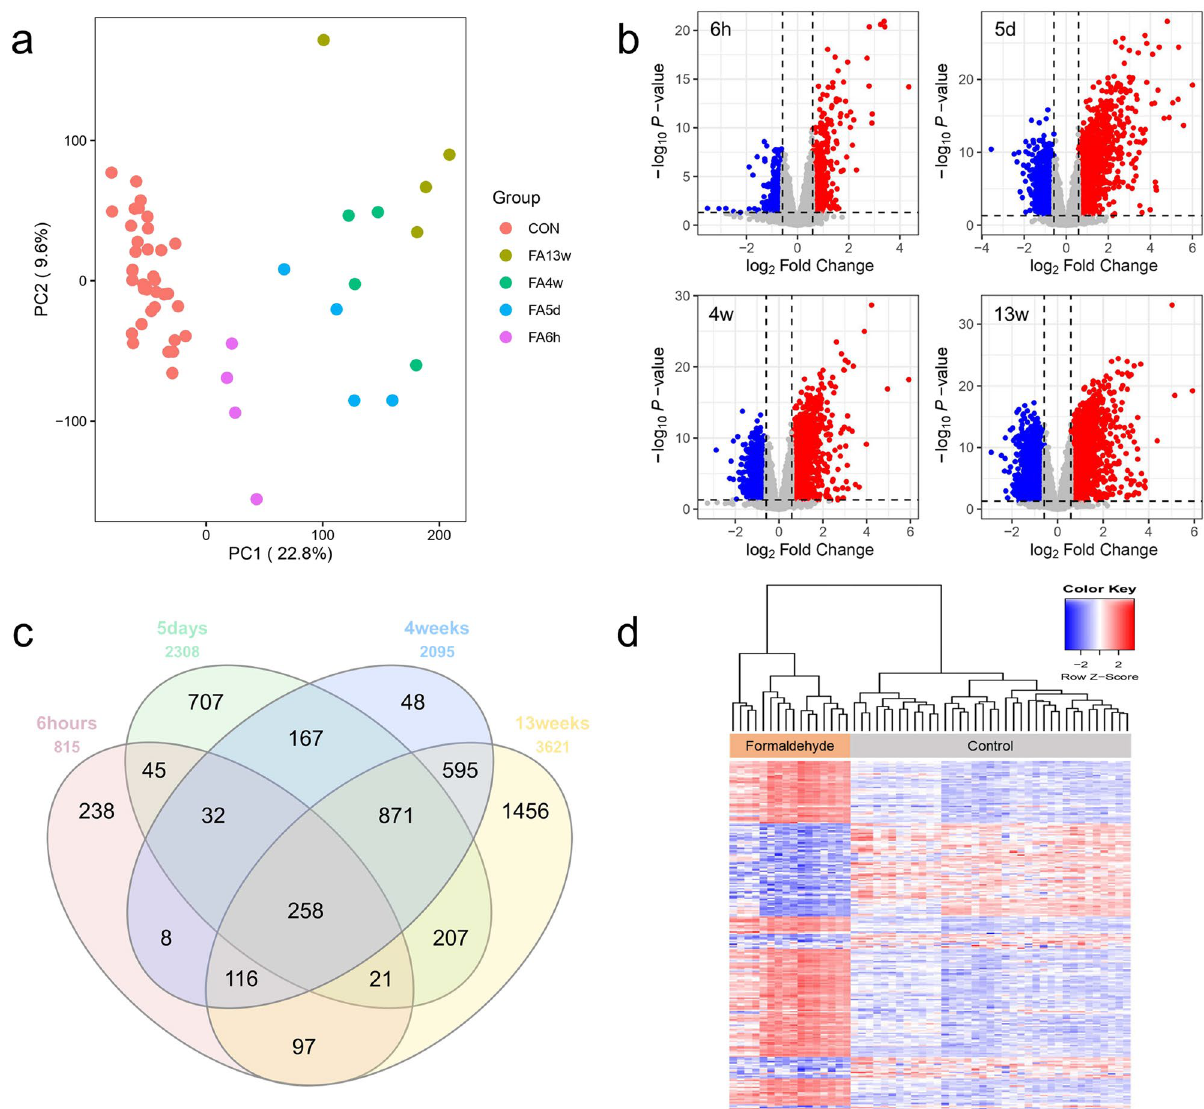
Figure 2. Clustering patterns of transcriptomic profiles and DEGs identification ( a ) Batch effect corrected-PCA result. PCA showed a distinct difference between the control and the exposure groups. ( b ) Volcano plot results of DEGs by each exposure groups. ( c ) Venn diagram of the DEGs among the formaldehyde exposure groups. ( d ) Hierarchical clustering heatmap of the common DEGs. All analyses were performed using R software (version